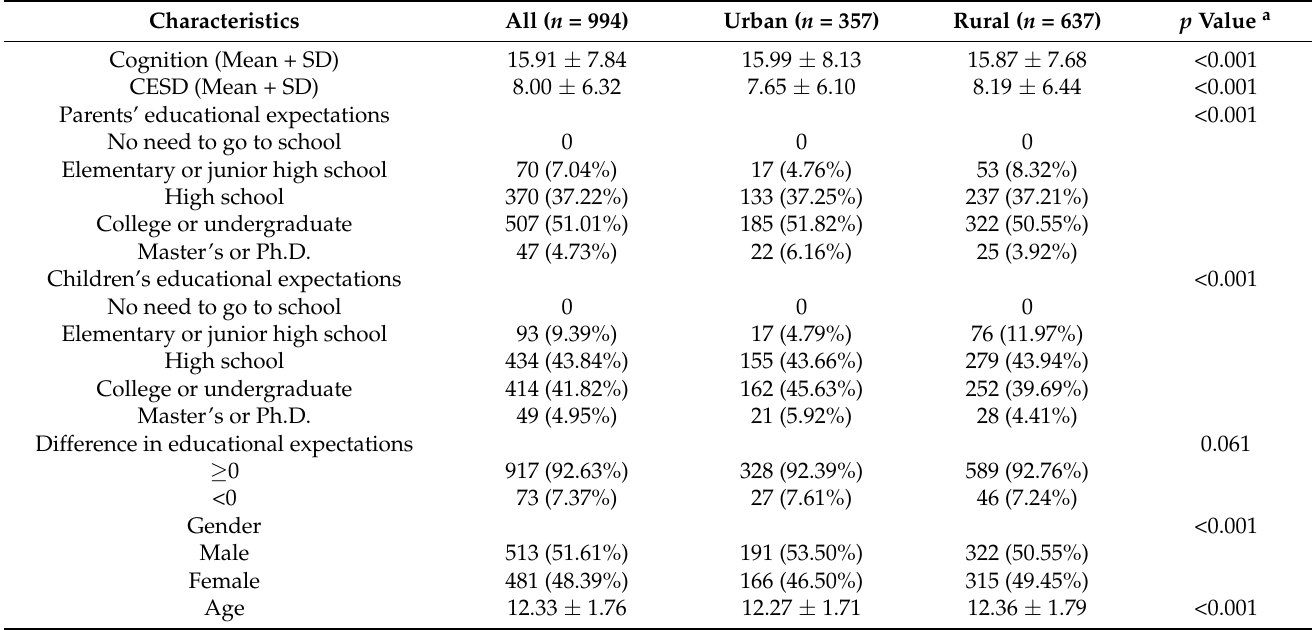
Table 1. Descriptive statistical